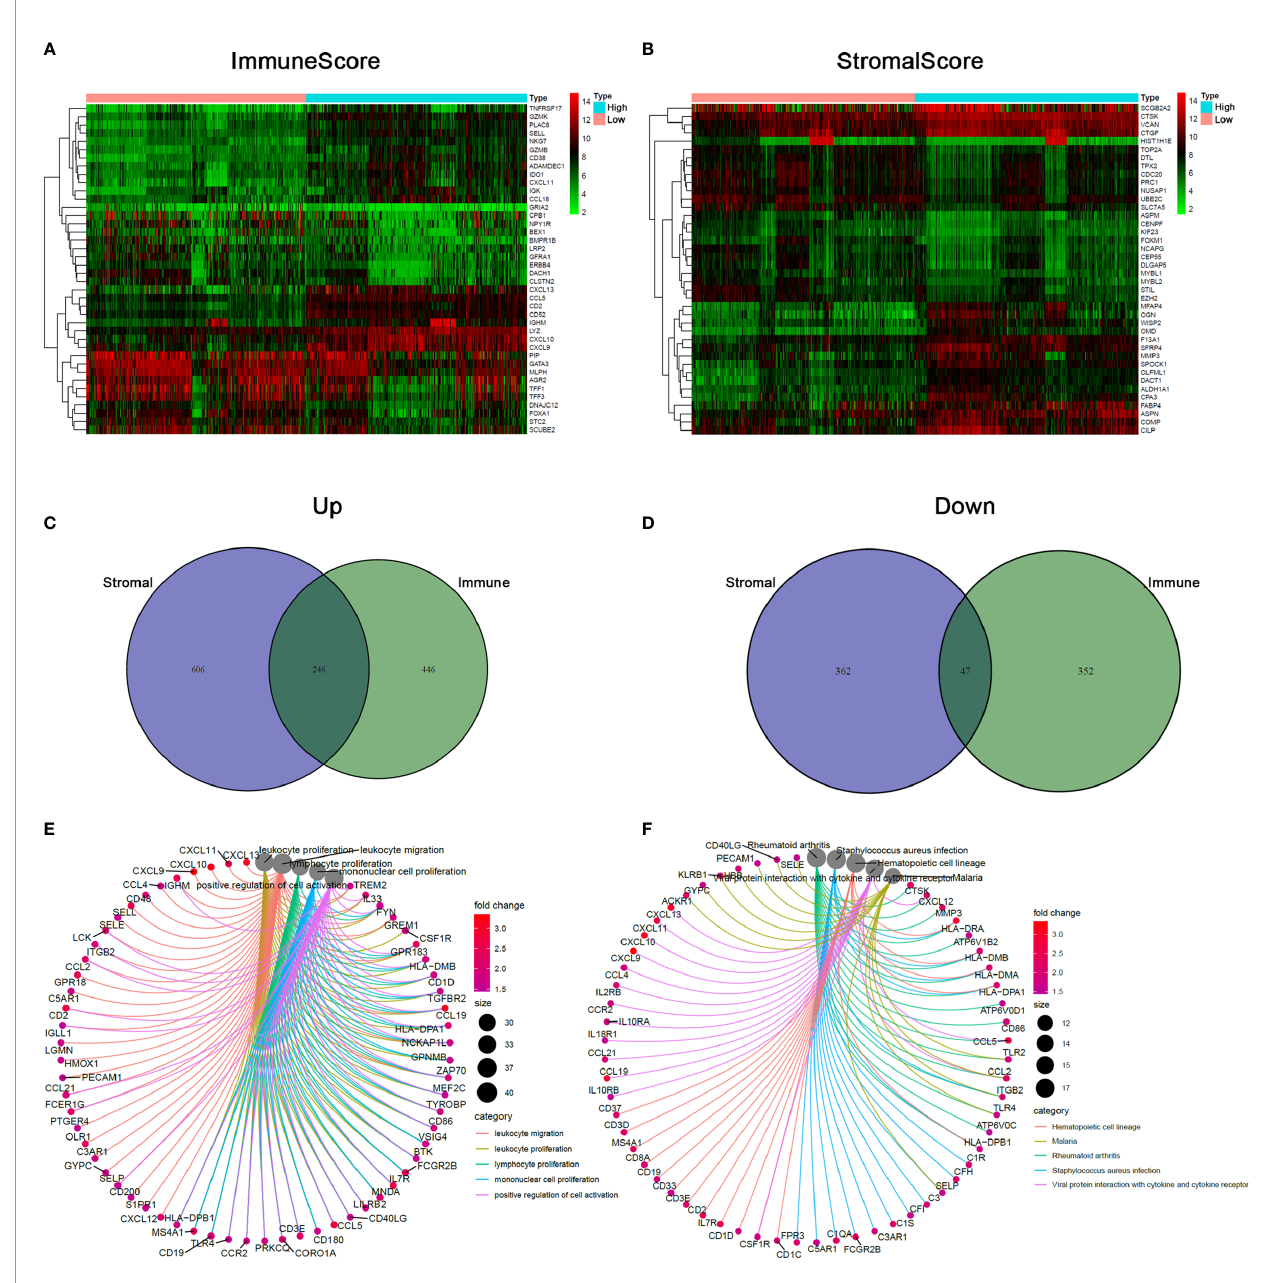
FIGURE 2 | Comparison of gene expression pro fi le with stromal and immune scores of BRCA. (A, B) The heatmap presenting the top 20 upregulated and downregulated DEGs in ImmuneScore and StromalScore. DEGs were detected by Wilcoxon rank sum test ( q < 0.05 & |log2FC| > 0.5). (C, D) Venn diagram analysis of aberrantly expressed genes based on stromal and immune scores. (E, F) DEGs-related biological functions and pathways in BRCA, terms with p and q < 0.05 were considered to be signi fi cantly